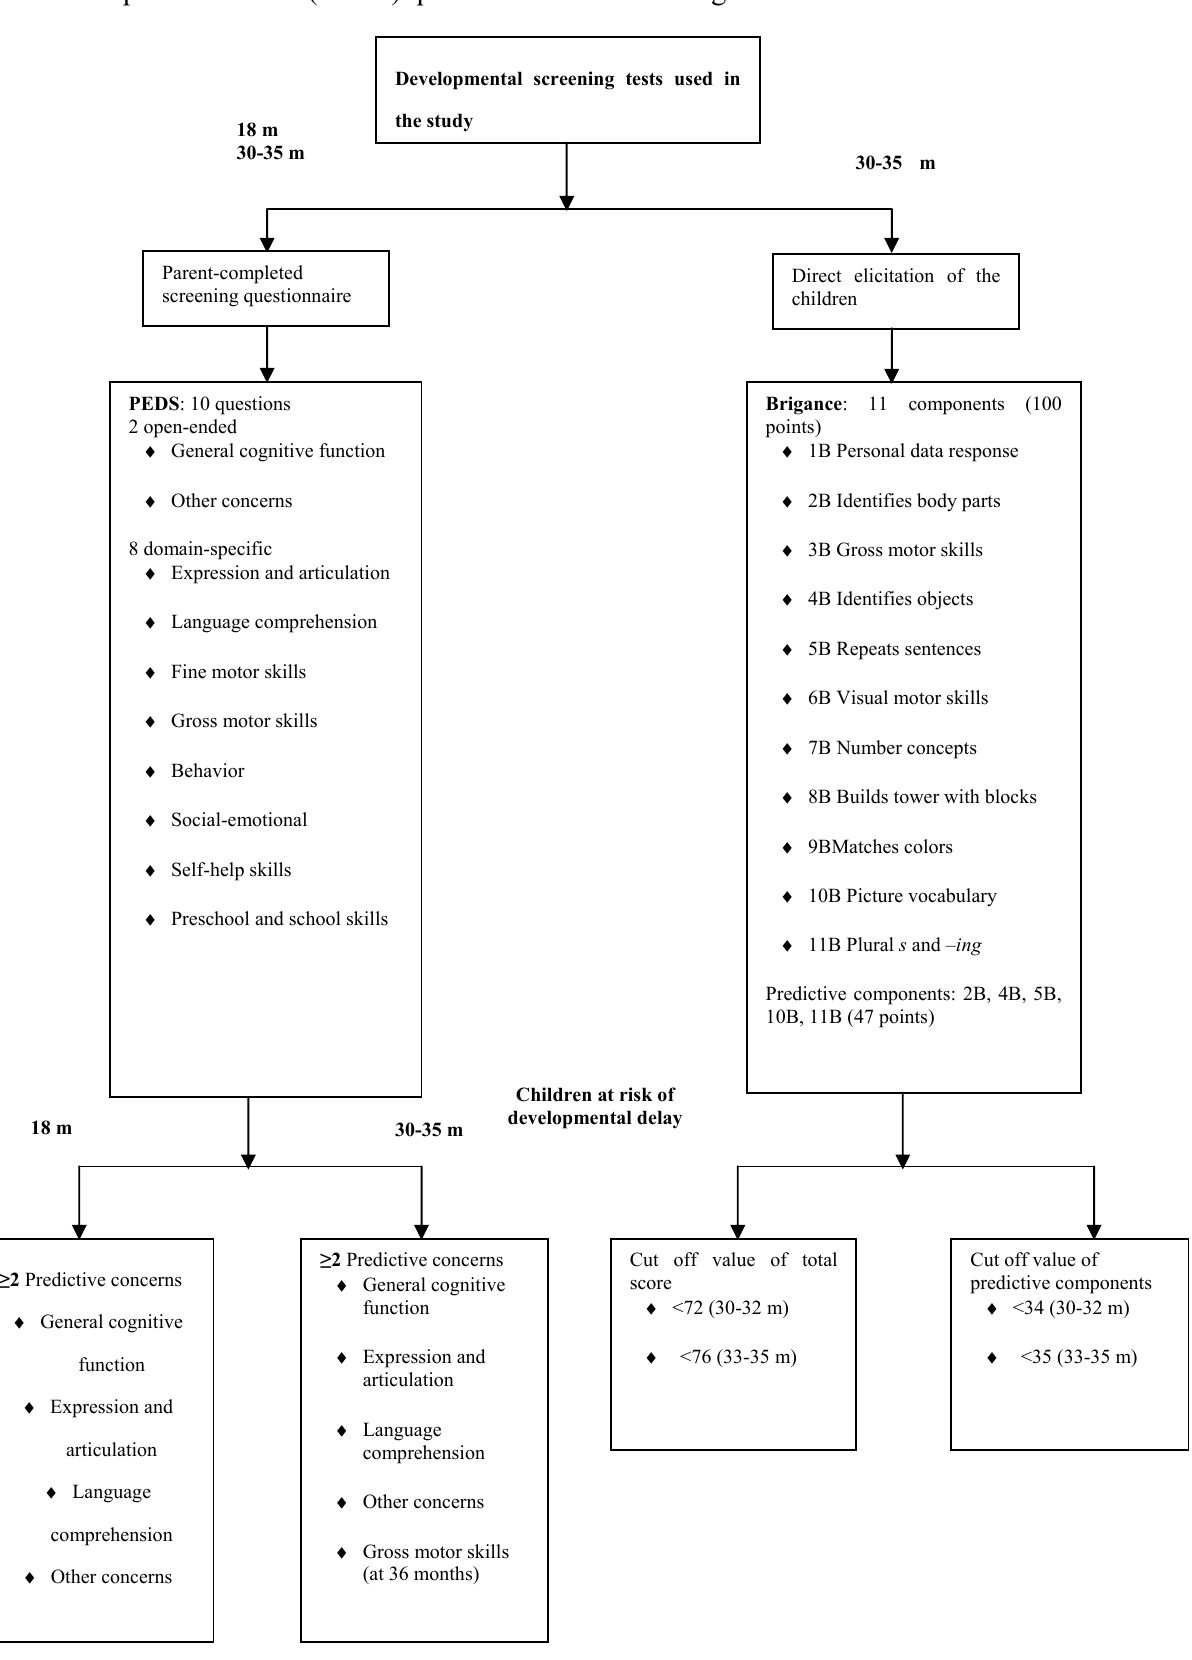
Figure 1. Developmental screening tests used in the study, the Parent’s Evaluation of Developmental Status (PEDS) questionnaire and the Brigance